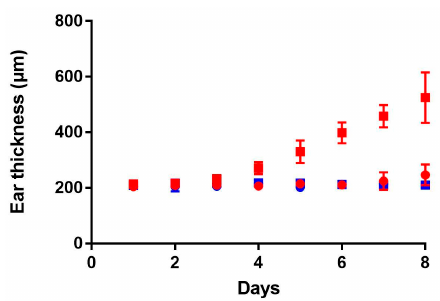
Figure 3. Evaluation of ear thickness during 8 days. Experimental group (daily IMQ application on the right ear) is shown in red squares and the control (left ear with Lanette application) is shown in red rounds; For control group, without any topical application, right ear is shown in blue squares and left ear in blue rounds. Data is presented as mean ± SD ( n = 15 for day 1 and decreased subsequently to n = 3 for day 8).